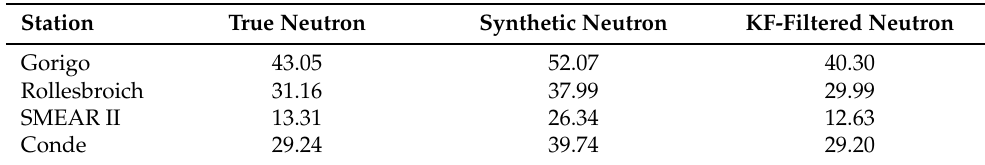
Table 2. Standard deviations of true neutron flux, the synthetic signal and the Kalman-filtered signal for the four